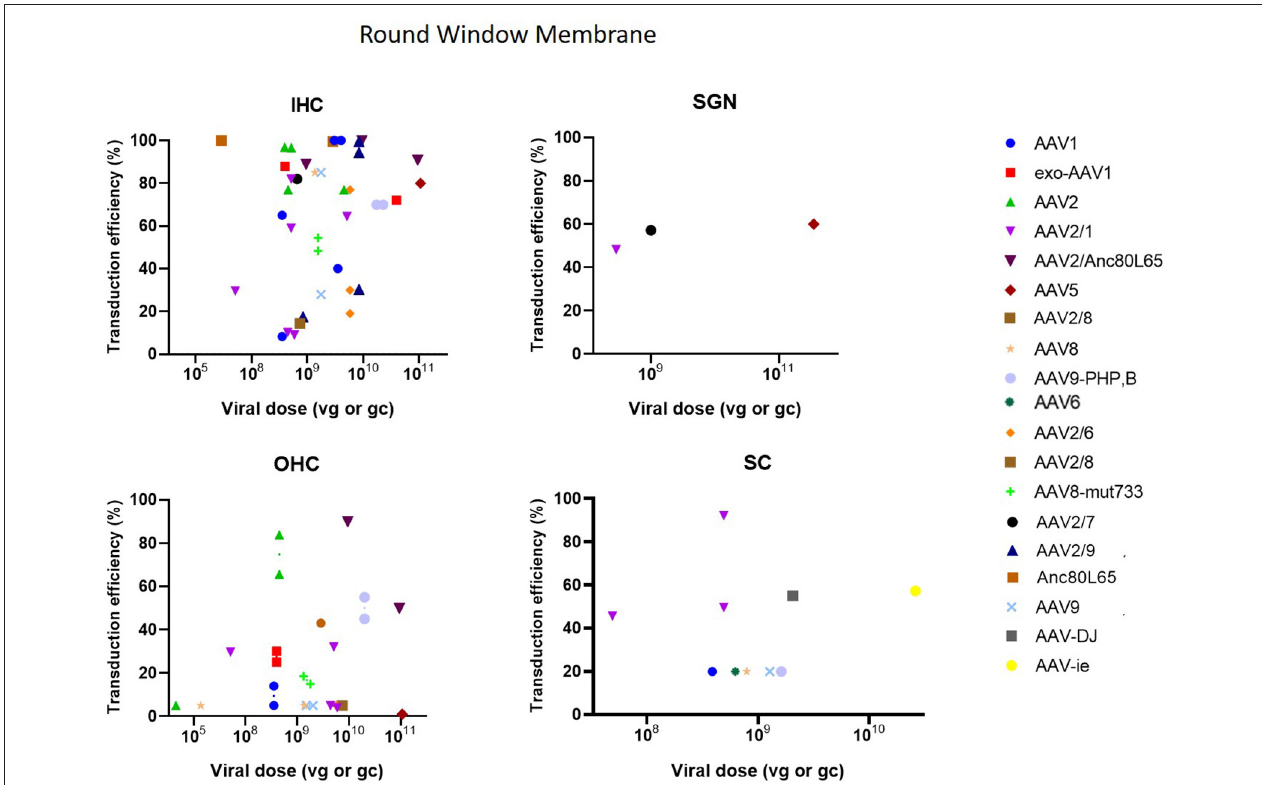
FIGURE 3 | Transduction efficiency of IHC, OHC, SGN and SC according to viral vector dose using the round membrane window approach. Only data from studies that performed inner ear application of AAV in mice were used to plot these graphs. IHC, inner hair cell; OHC, outer hair cell; SGN, spiral ganglion neuron; SC, supporting cell in organ of Corti; AAV, adeno-associated vector; gc, genome copies; vg, viral genomes.